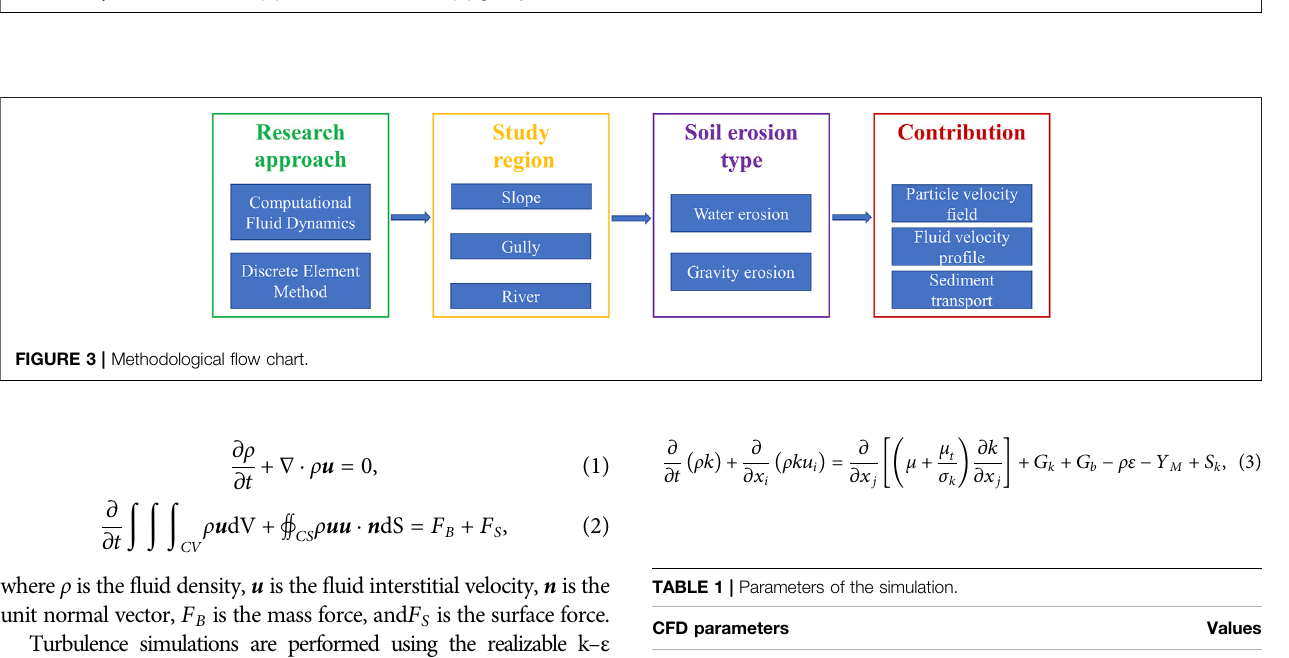
FIGURE 2 | Geometric models: (A) water erosion model; (B) gravity erosion model.